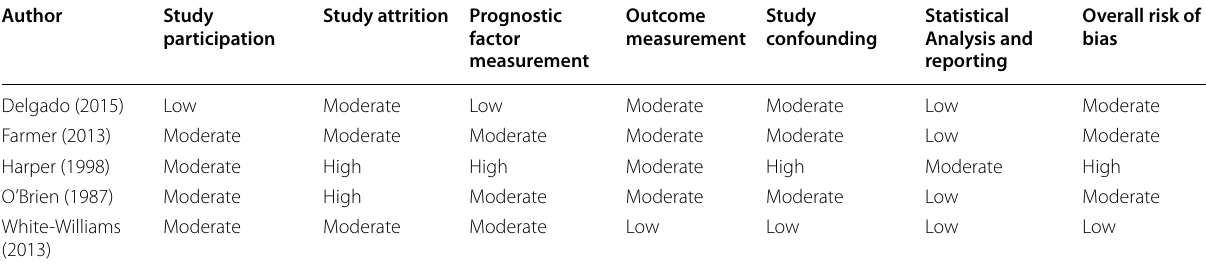
Table 4 Risk of bias